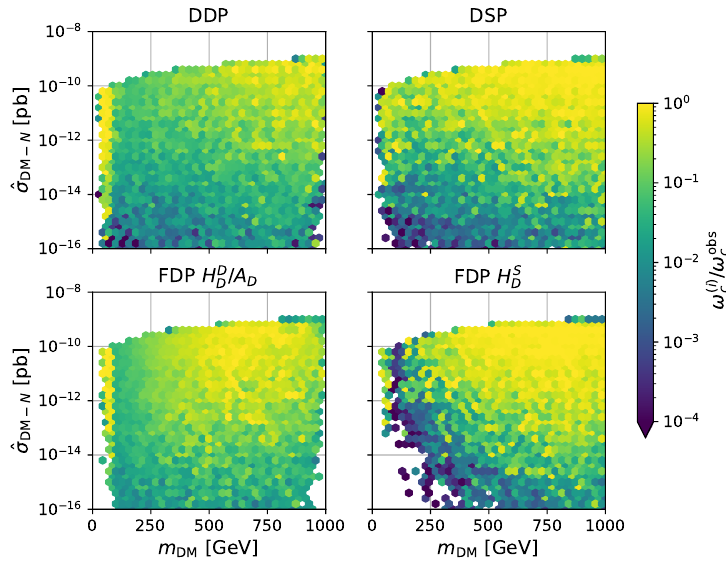
Figure 3 . Nucleon-DM cross section, ^ (cid:27) DM-N , as a function of the DM mass with all the constraints previously discussed. The colour code represents the fraction of the DM relic density, where the upper limit is the central value measured by Planck plus 2 (cid:2) 1 (cid:27) . On the left upper plot we show the DDP and take the lightest dark sector particle to be the dark matter candidate; on the upper right we show the DSP with the corresponding dark matter candidate. The lower plots show the FDP: here the DM particle is either H D or A D on the left and H S on the right; note that since the D D two symmetries are conserved separately there are always two dark matter candidates in the